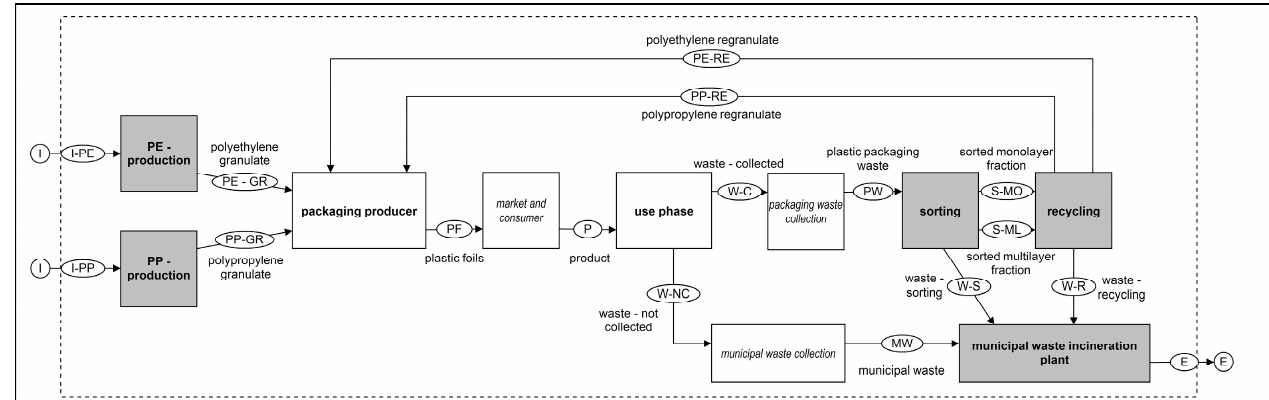
Figure 2. Product lifecycle of plastic